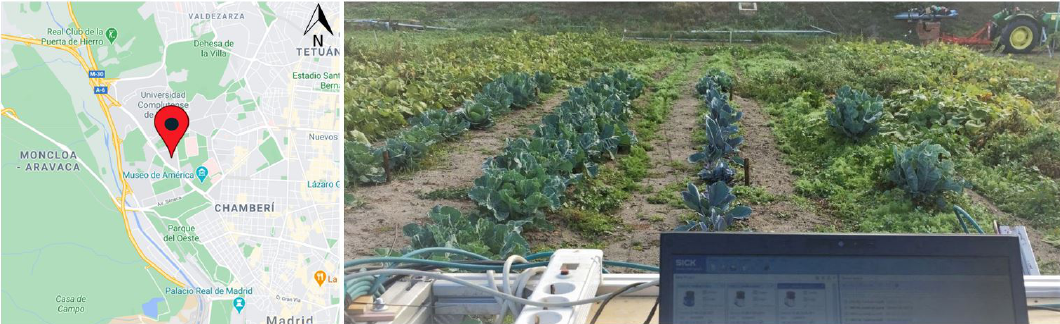
Figure 1. Test fields with single cabbage rows. Source: